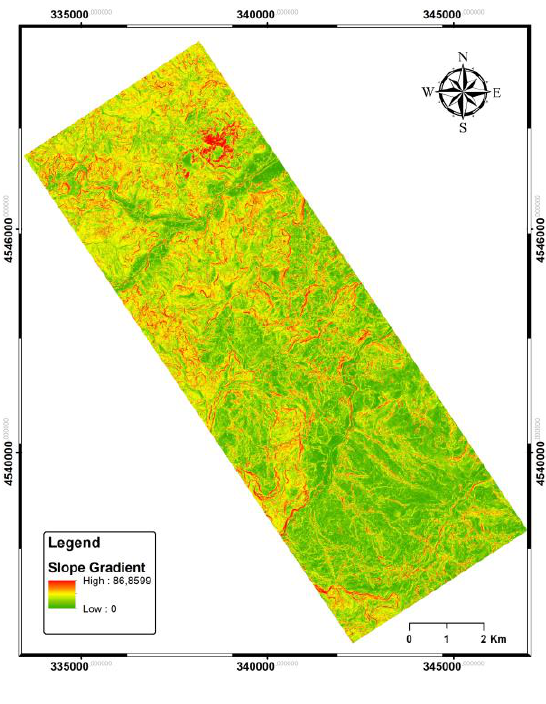
Figure 6. Slope gradient map of the study area.